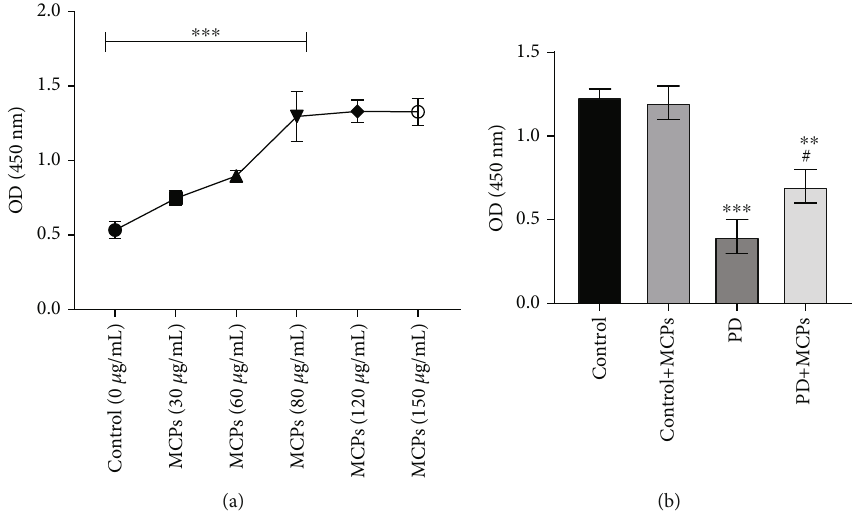
Figure 4: MCPs improve the viability of glioblastoma cells. (a) The e ff ects of di ff erent concentrations of MCPs (0 μ g/mL, 30 μ g/mL, 60 μ g/mL, 80 μ g/mL, 120 μ g/mL, 150 μ g/mL) on cell viability. (b) In the PD cell model, the e ff ect of MCPs on cell viability. Compared with the Control group (Control+MCPs group), ∗∗∗ P < 0 : 001 , and compared with the PD group, ## P < 0 : 01 , ### P < 0 : 001